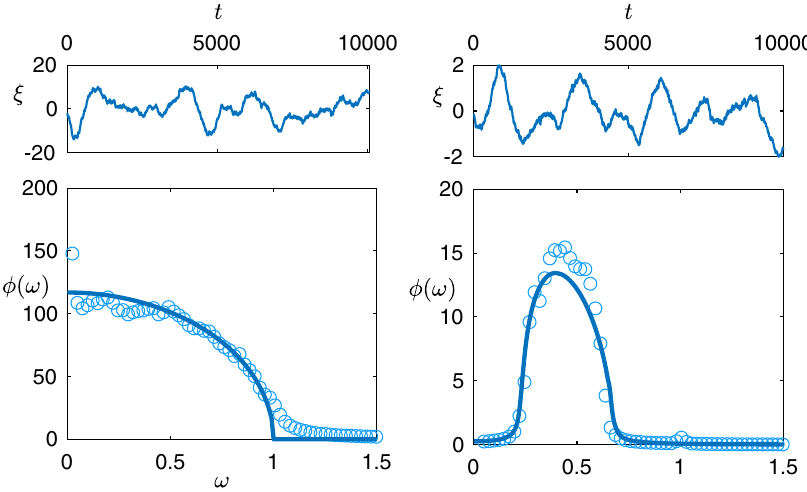
Fig. 1 Fluctuation spectra in predator-prey systems. Left: a mixed community of species with randomly assigned predation relationships. Right: a model ecosystem with two trophic levels — 200 predators and 800 prey species. In both cases fl uctuations are illustrated via a typical single-species time series ( ξ ( t ), upper) and the mean power spectra ( ϕ ( ω ), lower), where circles are simulation results, and solid lines our theory. Parameters are: N x = 200, N y = 800, c x = 20, c y = 5, α = 10, b = 1, d = 1; full details of all simulations are found in Methods